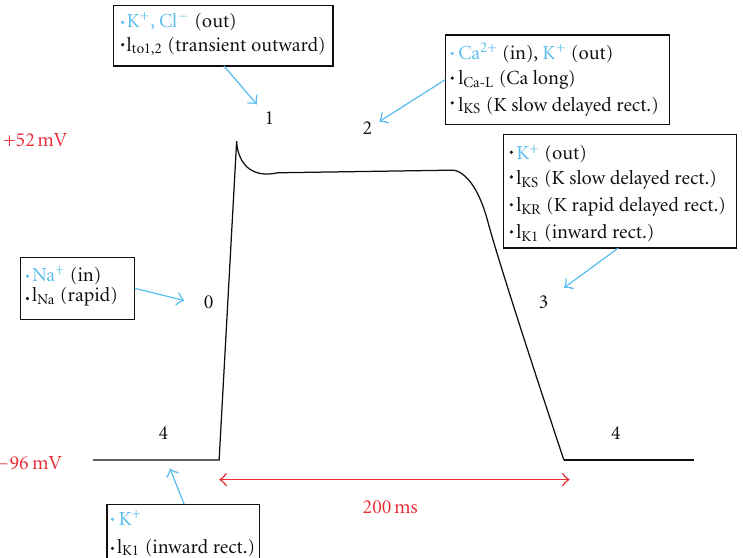
Figure 2: Myocardial action potential. Phase 0 rapid depolarization is mediated by sodium entry into cells. Phase 1 and 3 repolarization results from potassium e ffl ux from cells. Balanced slow calcium entry and potassium exit cause the plateau in phase 2. Potassium reenters and sodium exits cells during phase 4 recovery.